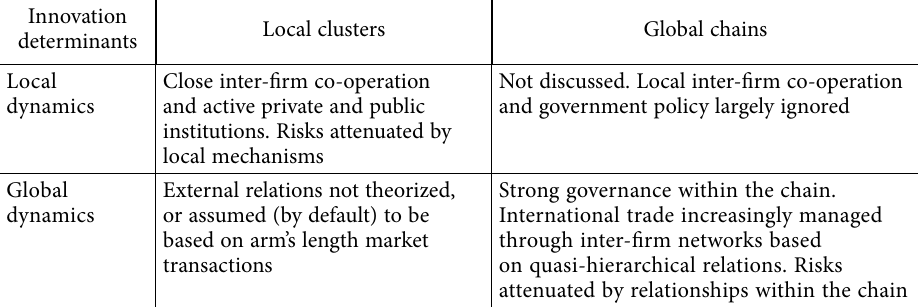
Table 3. Innovation under local vs global dynamics (source: authors’ summary based on literatures) Innovation